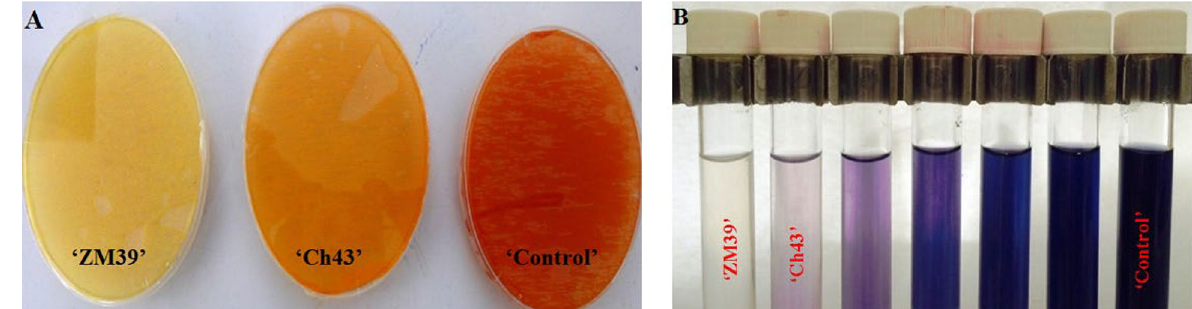
Figure 1. Color-based method for hydrogen cyanide (HCN) quantification in agar medium at the present of strains ‘Zm39’, ‘Ch43’, and no-strain (‘Control’) (A) , and starch hydrolysis method for assaying the amylase activity (B) under drought stress induced by PEG 6000